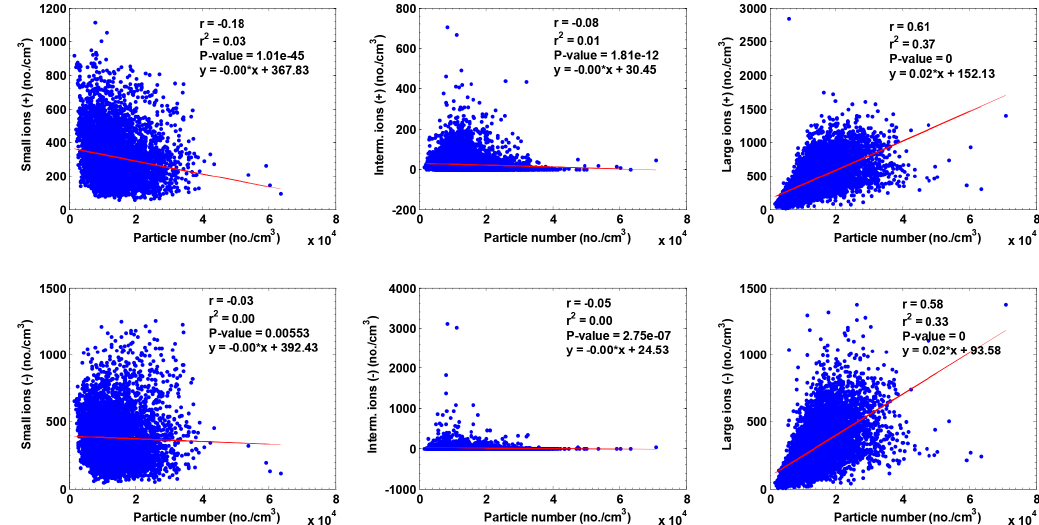
Figure A1. Correlation between particle number concentrations and ions (small: 0.8–2nm; intermediate: 2–7nm; large: 7–20nm).